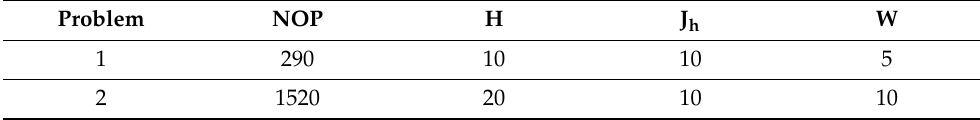
Figure 5. Procedure to set the initial schedule using a genetic algorithm. 3.2. Modi fi ed Bo tt leneck Minimal Idleness Here, the order of the parts (refer to Figure 3) to be processed for all products on every workstation is collectively decided. Initially, the set of operations for every work- station is identi fi ed for all products, and subsequently, the bo tt leneck workstation that consumes the most processing time is identi fi ed. Secondly, for each part of the bo tt leneck station, the sum of the processing times of the remaining operations, called the tail, is estimated. Subsequently, the total processing time at the bo tt leneck station for every prod- uct is calculated, and the sequence of the products is determined in decreasing order of time. Followed and continued to club, the operations on parts at the bo tt leneck station belonging to each product and arranging them in sequence is determined earlier. Thus, for each product, the operations at the bo tt leneck station are sorted in decreasing order of closeness to the secondary bo tt leneck workstation upstream. Finally, the schedule is set by aligning the remaining operations before and after the bo tt leneck station and deter- mining the make-span. 4. Proposed Approach For the above-stated assembly fl ow-shop problem with machining operations in the fi rst stage and assembly operations at a later stage, in order to accommodate disruptions in the manufacturing and assembly processes, the rescheduling process needs to have the